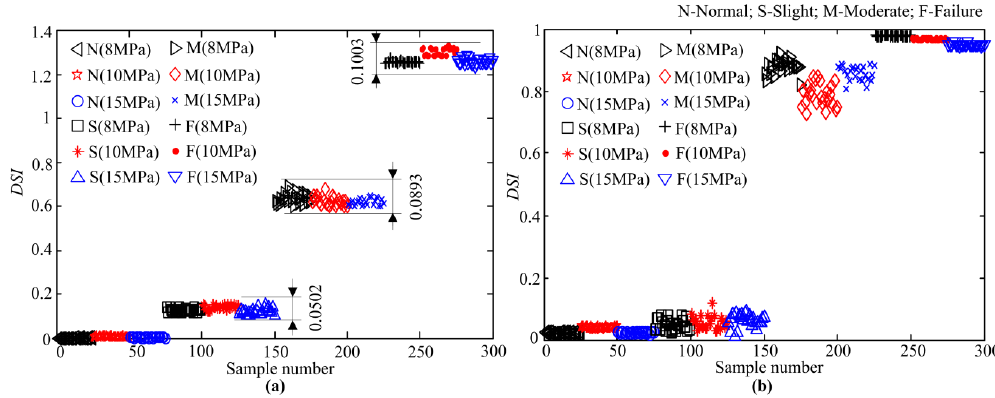
Figure 15. The recognition results based on ( a ) support vector data description (SVDD) and ( b ) fuzzy c-means clustering (FCM).